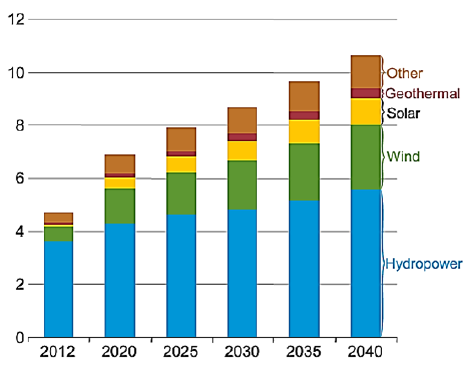
Figure 1. World net electricity generation from renewable power by fuel for trillion kWh [36].